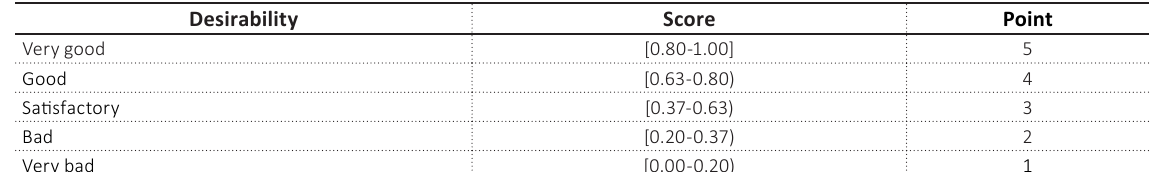
Table 7. Distribution of points for cluster